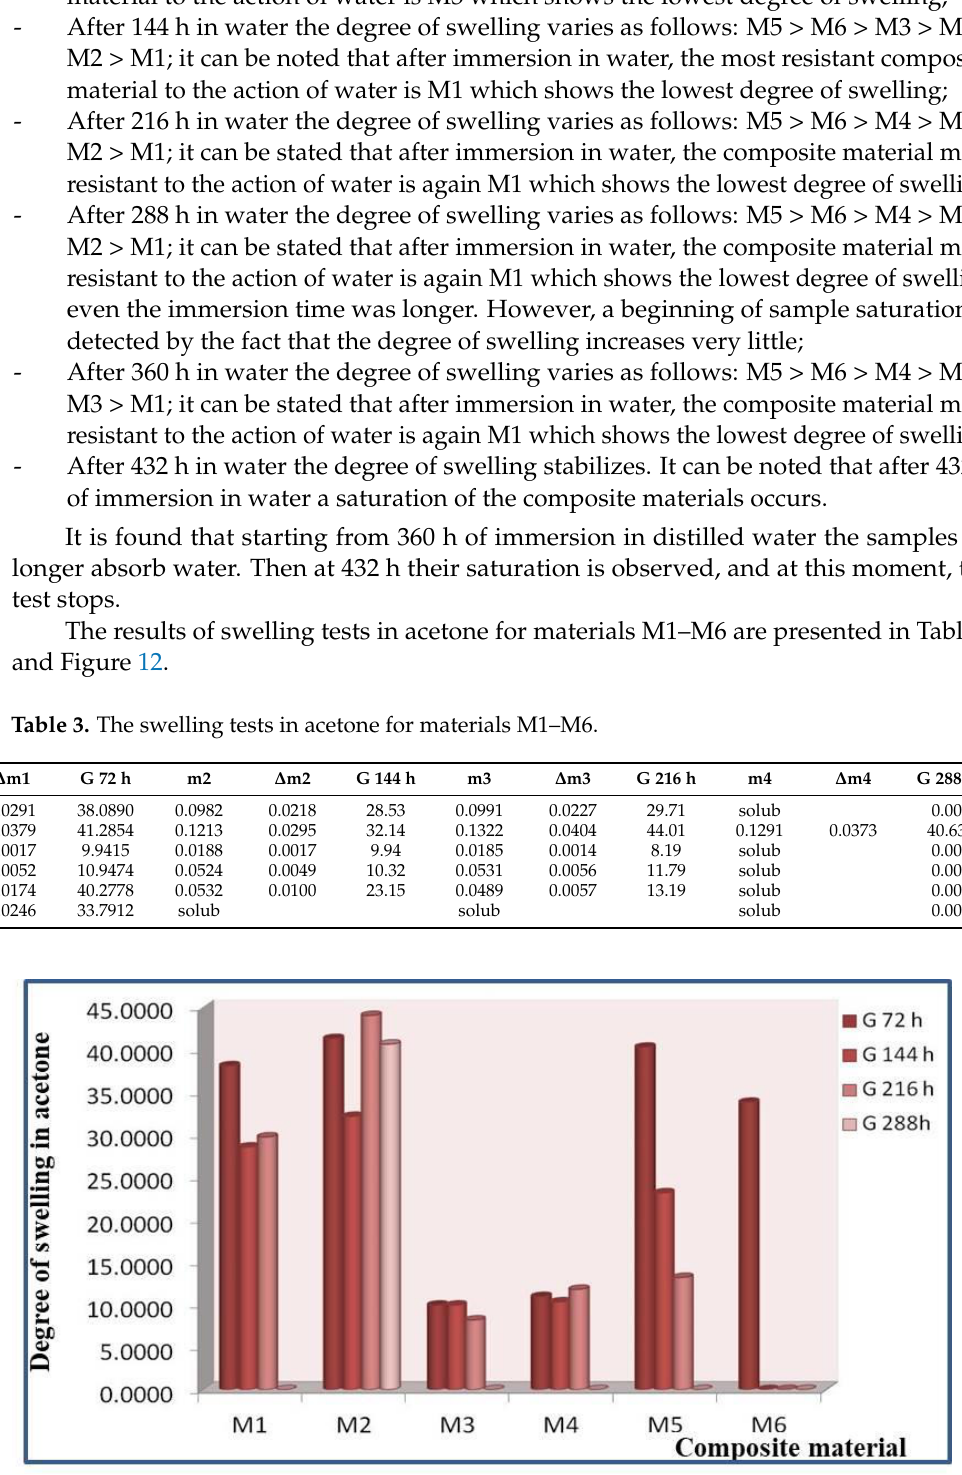
Figure 12. Swelling in solvent (acetone) for materials M1 – M6.